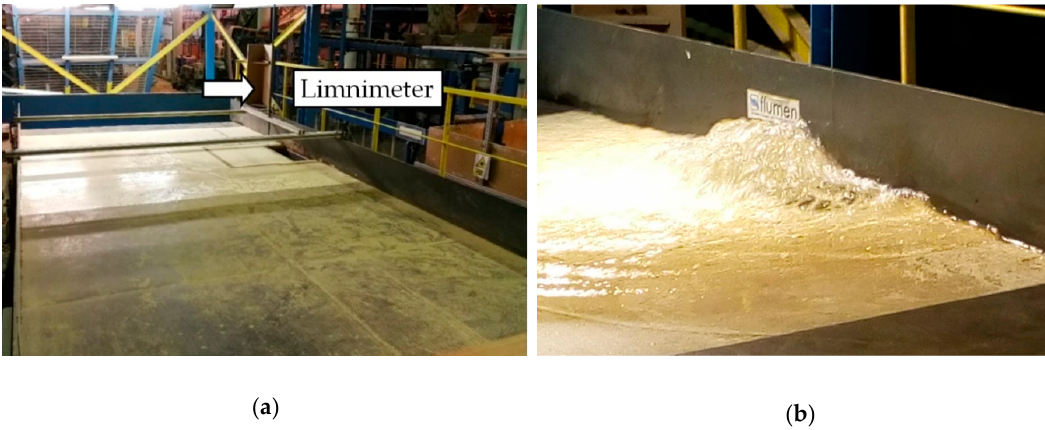
Figure 4. ( a ) Structure to support the limnimeter to read water levels over the grate; ( b ) Test of 40 L/s, 0% longitudinal slope for the Barcelona1 0% longitudinal slope for the Barcelona1 grate.